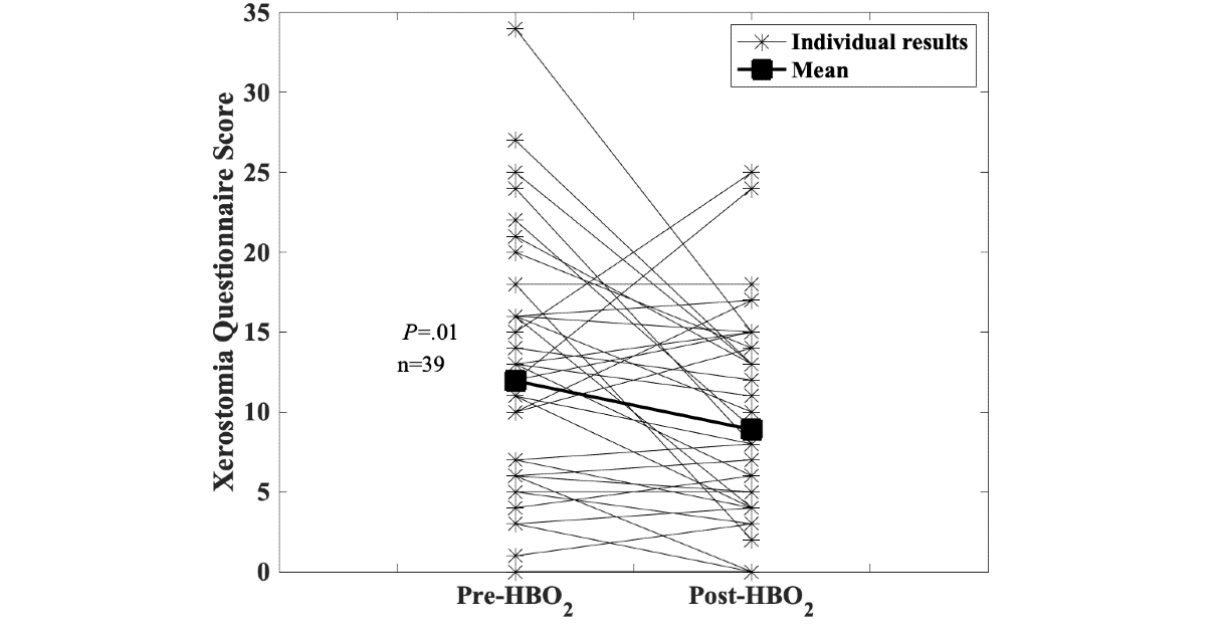
Figure 2. Delayed radiation injury. Scores on the xerostomia (ie, dry mouth) questions within the Head and Neck Questionnaire are shown: lower scores indicate fewer symptoms. Dry mouth is a common complication of head and neck radiation, and whether hyperbaric oxygen (HBO 2 ) helps with this symptom is an open question. Early results from the registry suggest improvement (11.9 pretreatment to 8.9 posttreatment, P =.01, Wilcoxon signed-rank